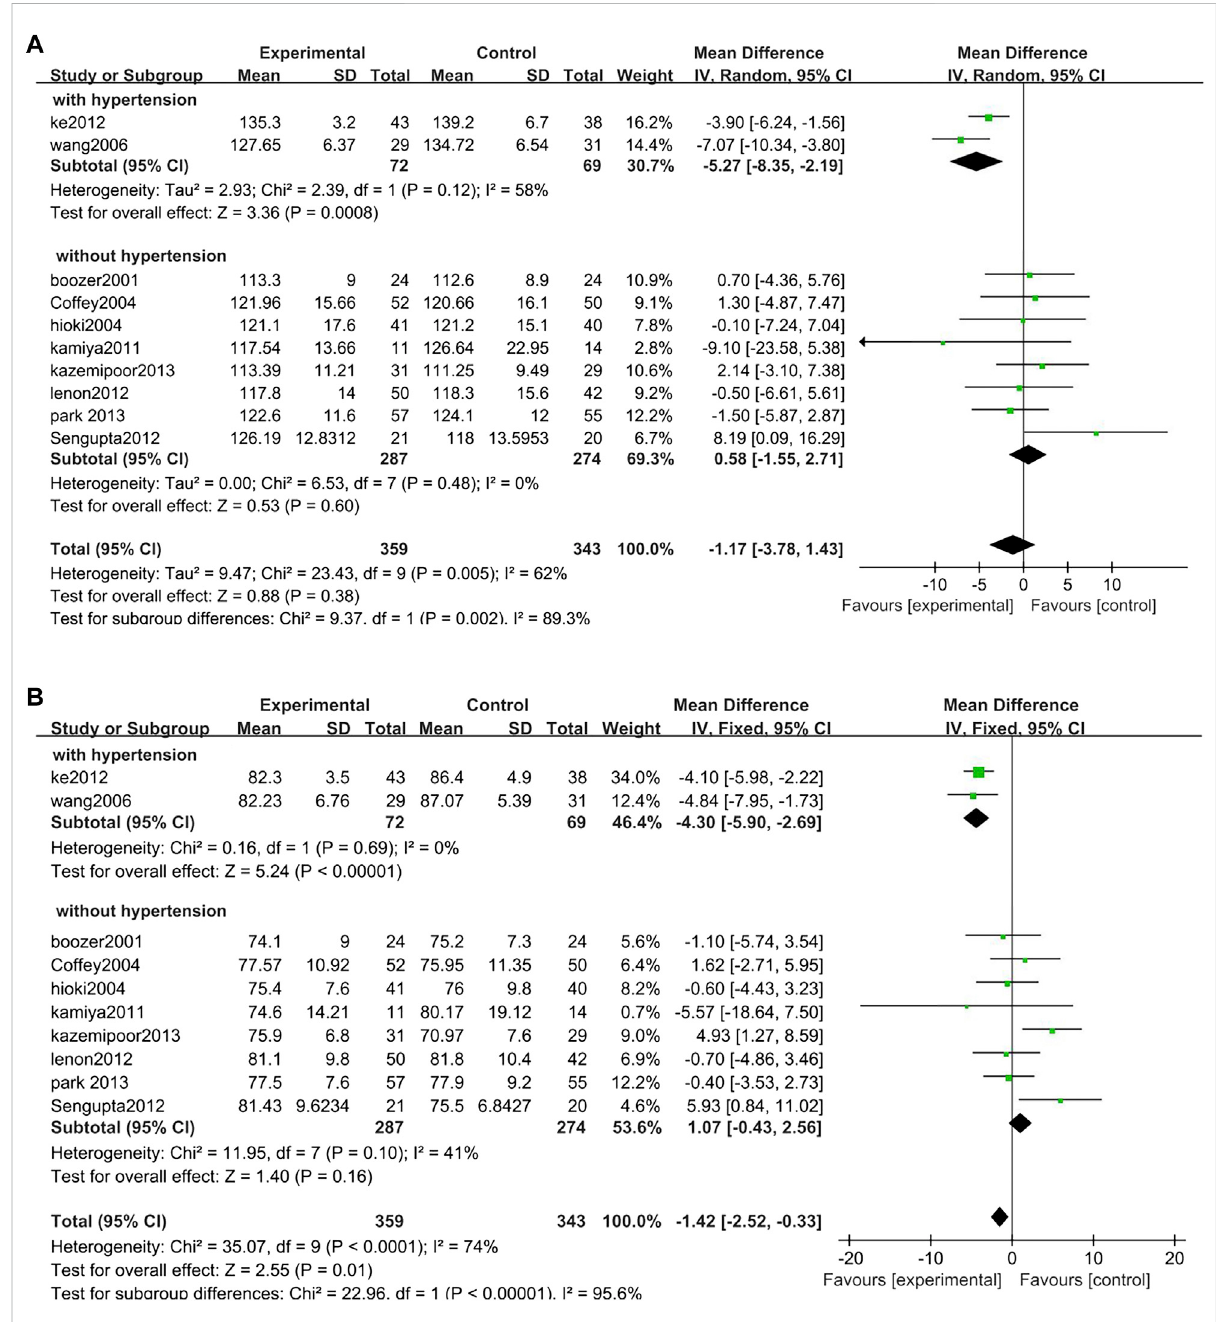
FIGURE 14 Forest plot of blood pressure. Comparison: TCM treatment vs. placeo or blank control. (A) Forest plot of SBP. (B) Forest plot of DBP.